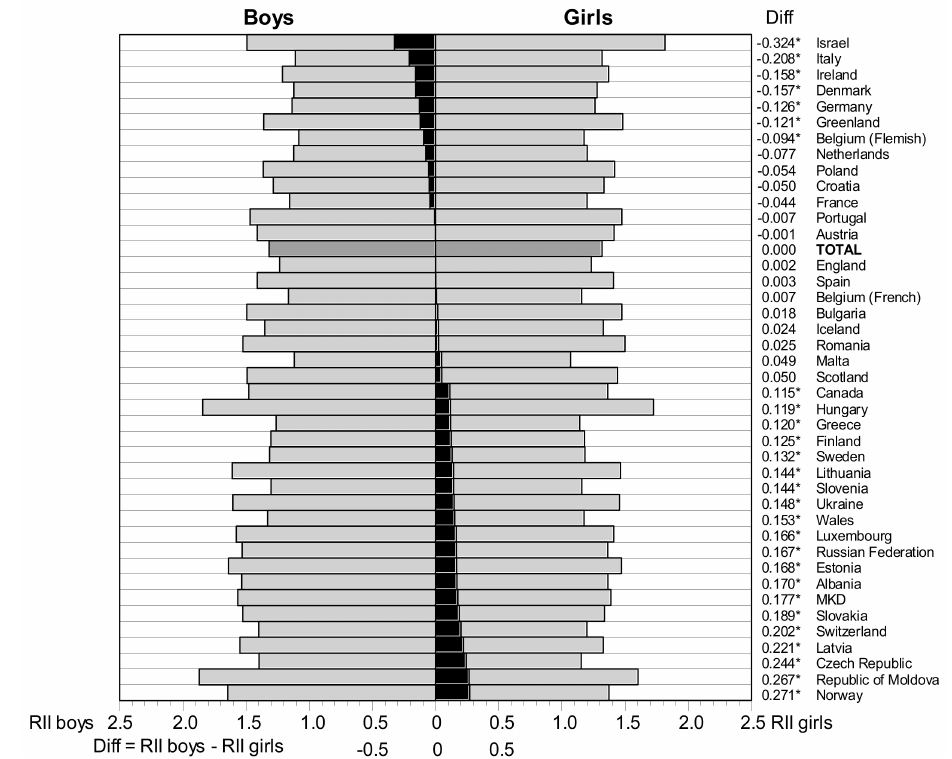
Figure 1. Relative Indices of Inequality (RII) in life satisfaction among boys and girls and their differences (black bars) in HBSC countries. * p < 0.05 that difference =